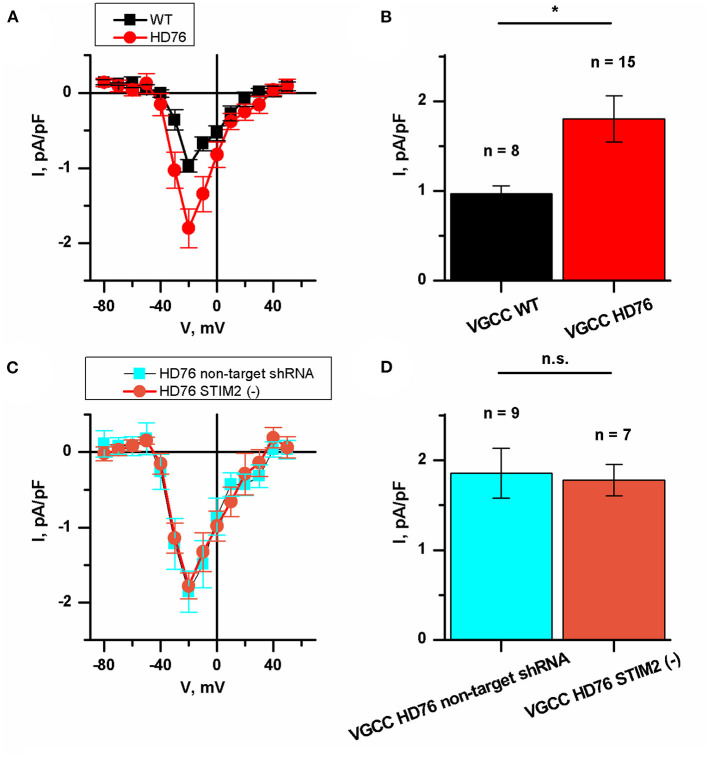
Disturbance of VGCC in HD76 neurons. (A) Average I–V curves of normalized voltage-gated calcium currents for HD76 (red circles) and WT (black squares) GABA MSNs. The number of experiments is depicted at the panel (B). (B) Average amplitude of VGCC currents at the potential of −20 mV for HD76 (red), and WT (black) GABA MSNs. The amplitudes are plotted as the mean ± SEM (n = number of single cell experiments). The asterisk indicates that differences in amplitudes are statistically significant (p < 0.05). (C) Average I–V curves of normalized voltage-gated calcium currents in HD76 expressing non-target shRNA (HD76 non-target shRNA, cyan squares) and HD76 expressing shRNA against STIM2 (HD76 STIM2(–), orange circles). The number of experiments is depicted at the panel (D). (D) Average amplitude of VGCC currents at the potential of −20 mV for HD76 expressing non-target shRNA (HD76 non-target shRNA, cyan) and HD76 expressing shRNA against STIM2 (HD76 STIM2(–), orange). The amplitudes are plotted as the mean ± SEM (n = number of single cell experiments). n.s. indicates the absence of statistically significant differences (p > 0.05).